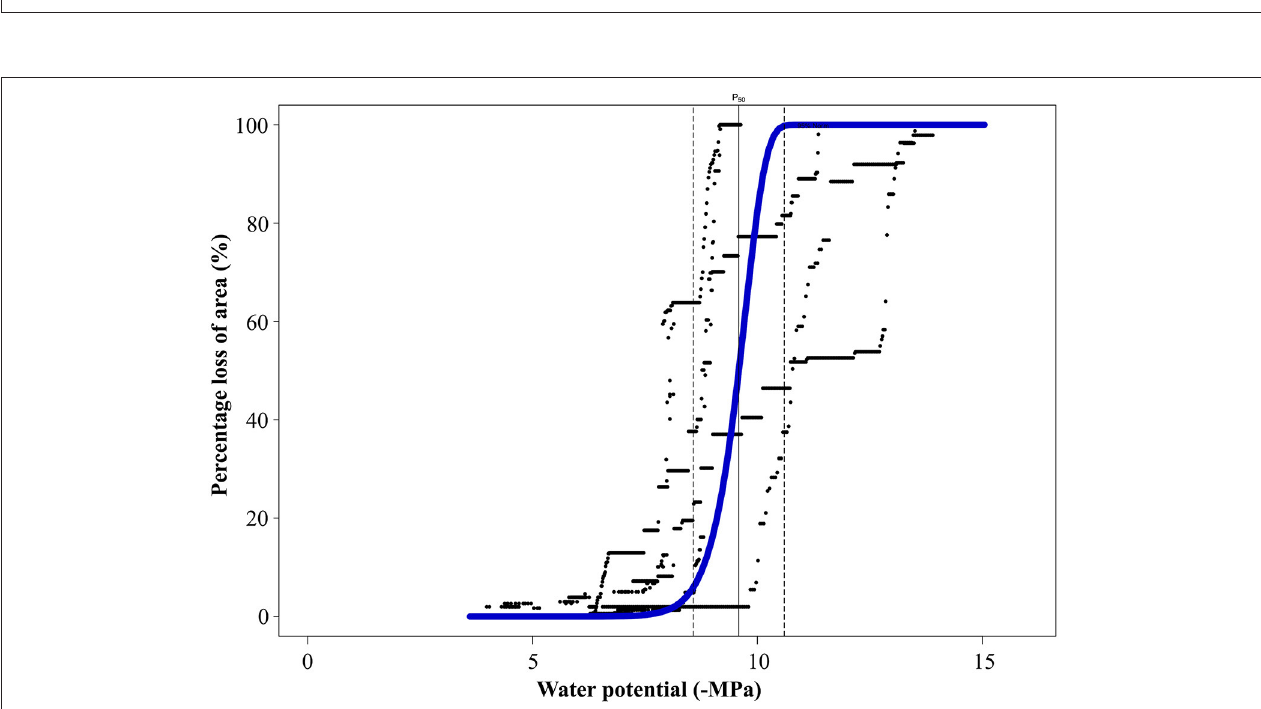
FIGURE 3 | Vulnerability curve (VC) from A. marina trees sampled on the sites of minimal impact showing the percentage of loss of area (PLA, %) against the water potential ( 9 x , -MPa). The average VC (blue) was built from 5 individual VCs (black). The vertical line shows 9 50 and the dotted lines the 95% confidence intervals for 9 50